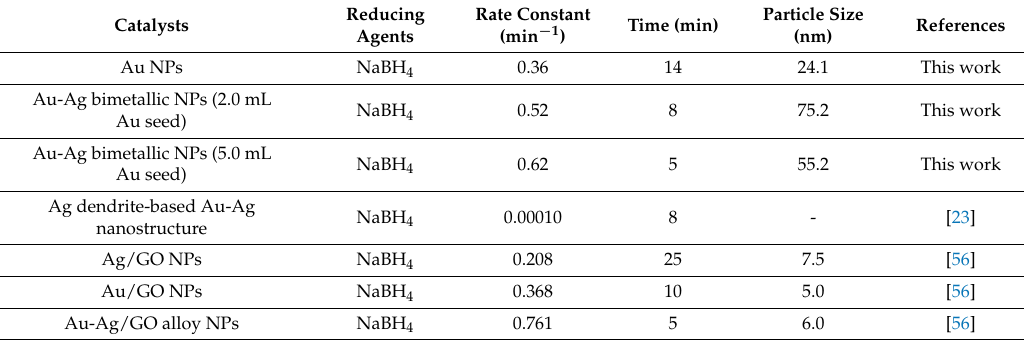
Table 2. Comparison of the catalytic reduction of 4-NP by Au and Ag